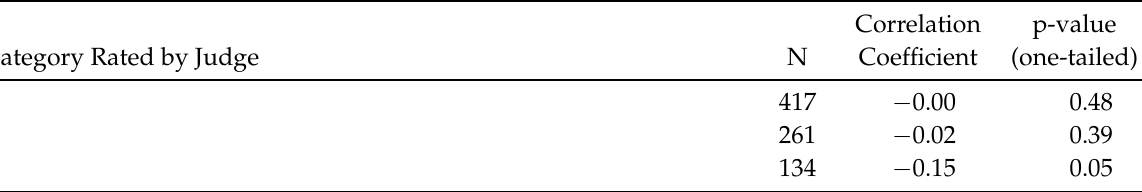
Table 4: Objective similarity of judge’s and target’s